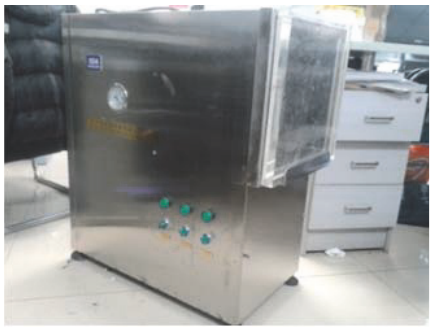
Figure 14: Vacuum deaeration tank.